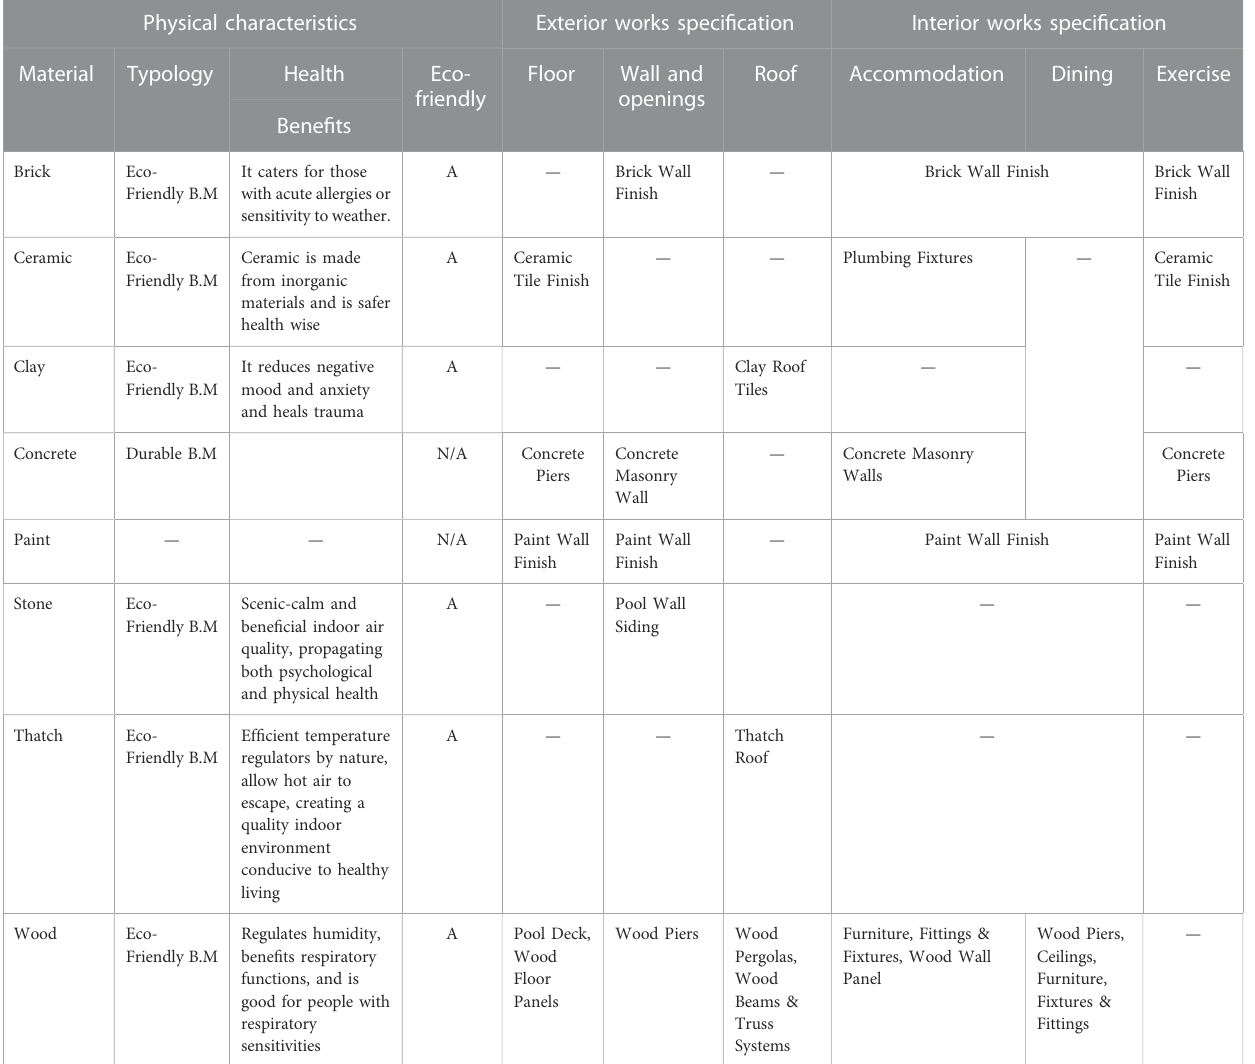
TABLE 6 Salinas Maragogi (Maragogi,